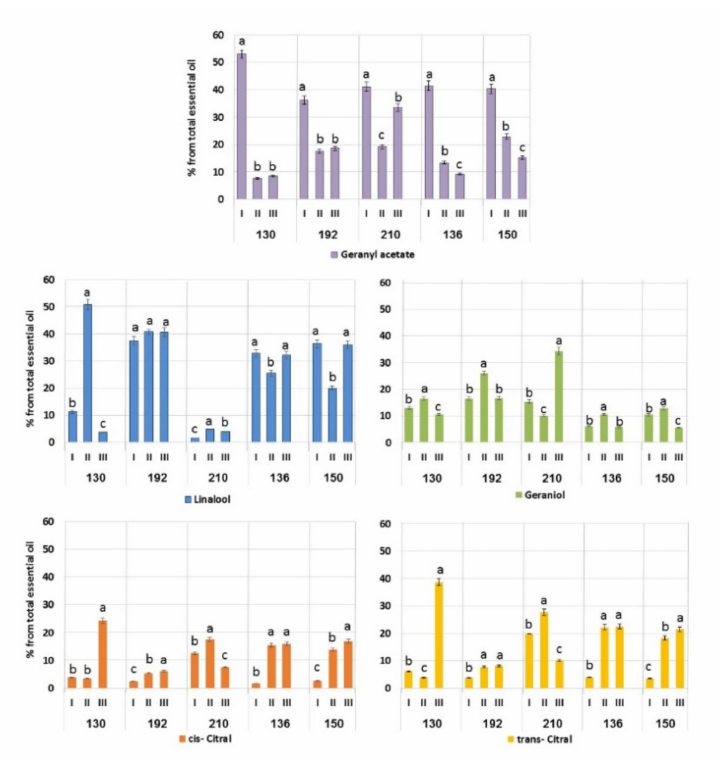
Figure 1. Accumulation of dominant components in the essential oil of cultivars 130, 192, 210, 136, and 150 of A. balchanorum at three stages of development, shown as a percentage from the total amount of essential oil. I—vegetative stage: during the spring regrowth at the end of May 2019, the entire annual shoots were sampled; II—flower buds: the tops of the stems with closed buds were sampled in mid-October 2019; III—flowering: the tops of the stems with inflorescences were sampled in mid-November 2019. Each dominant compound was analyzed separately in each cultivar for the differences between the stages. Bars represent standard deviation. One-way ANOVA and Student’s t -test were applied. Levels not connected by the same letter are significantly different ( α = 0.05).